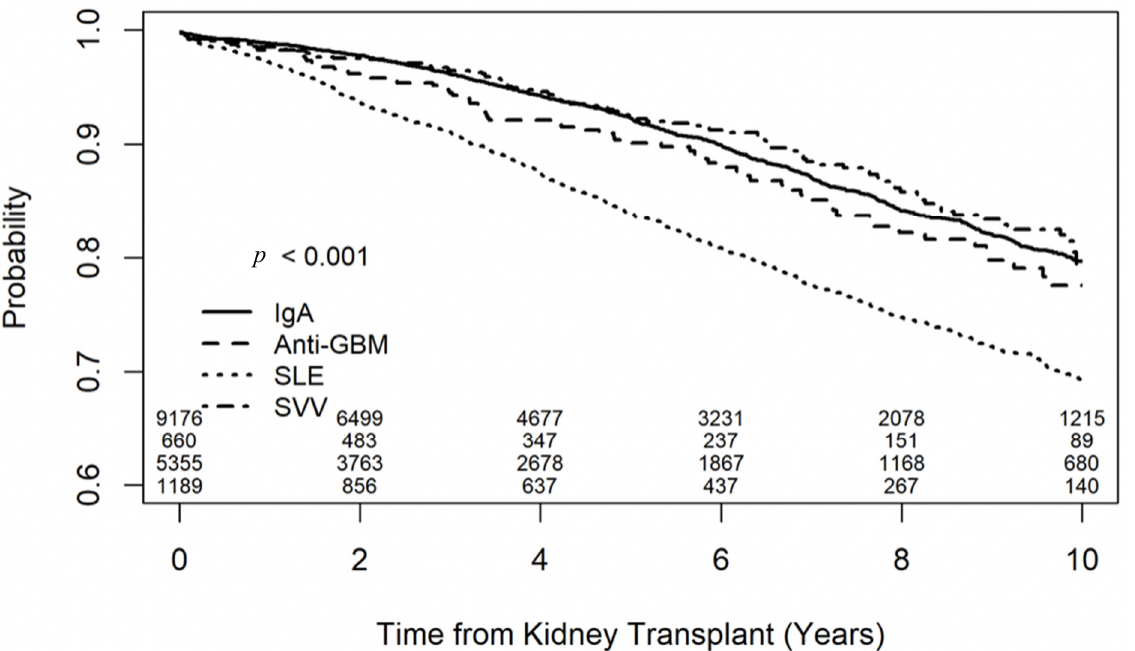
Figure 3. Death-Censored Graft Survival by Glomerulonephritis Type.